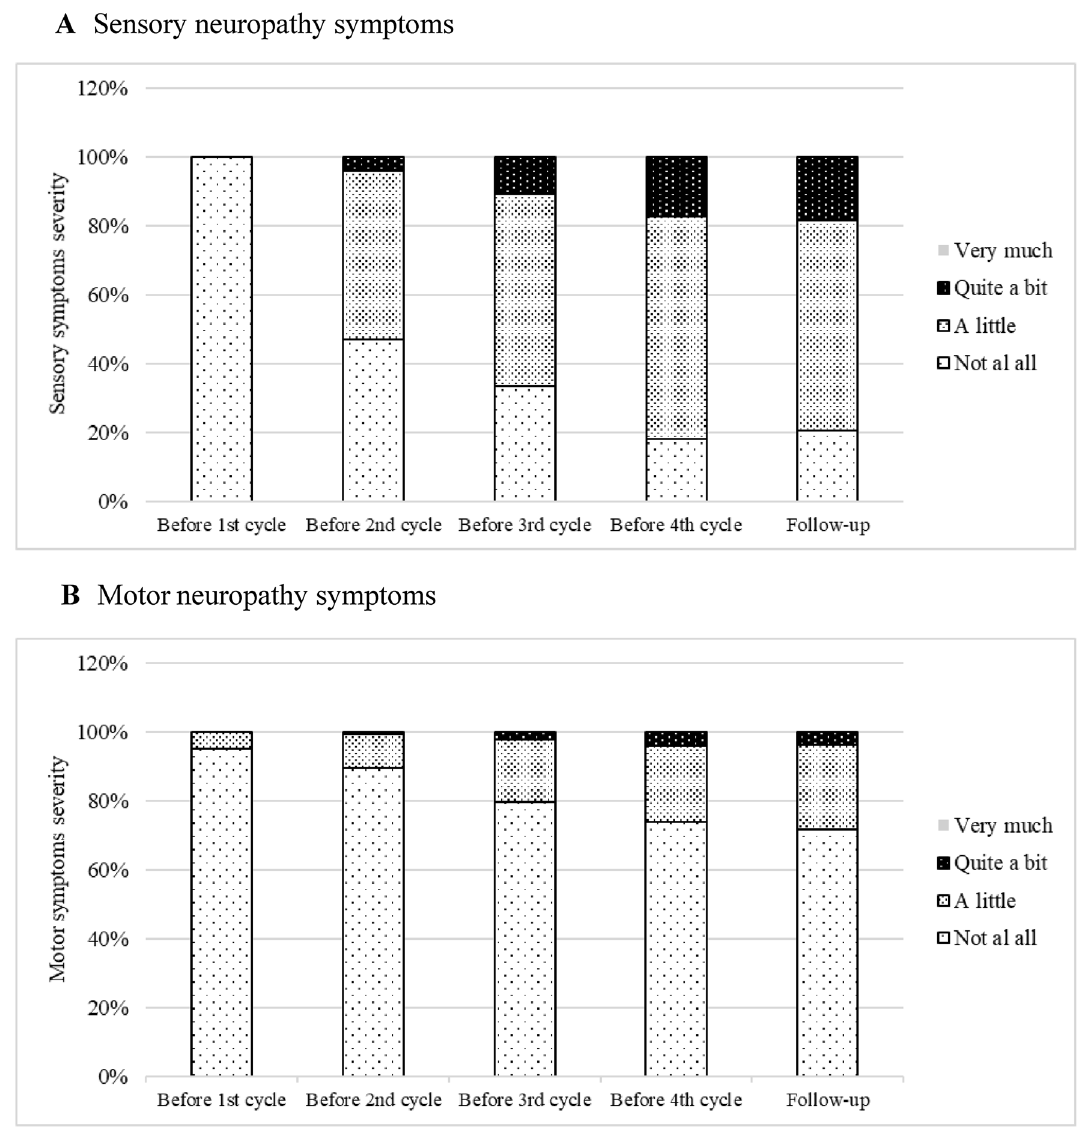
Figure 3. TIPN symptoms severity among participants during received taxane-based chemotherapy. ( A ) Sensory neuropathy, ( B ) Motor